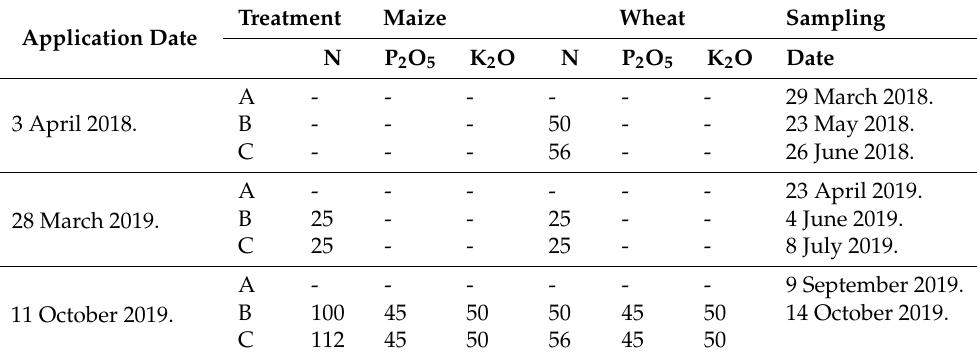
Table 2. Date and quantity (kg ha − 1 ) of fertilizer application prior to the samplings on the cropland site and dates of sample collection. A: no fertilization, B: NPK+manure, C: NPK. NPK: Nitrogen, Phosphorus, Potassium. Manure is applied in each 4th